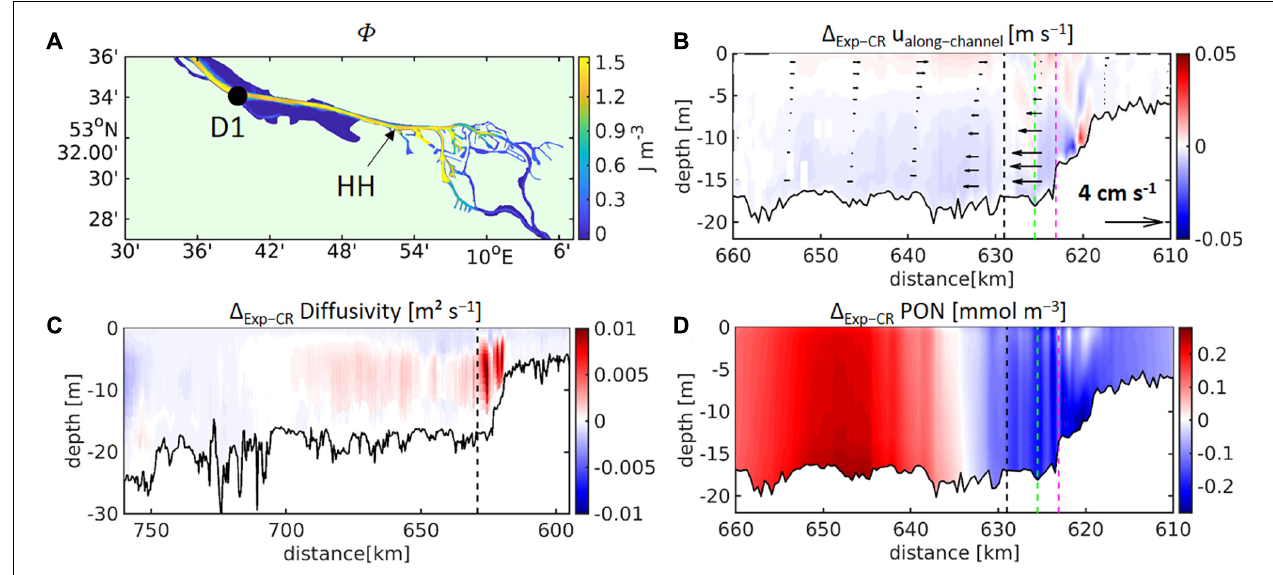
FIGURE 12 | (A) The vertically averaged and time-averaged potential energy anomaly ( (cid:56) ) is given for the focal region of the study, whereas (B) represents the along-channel profile of time-averaged differences experiment-control run ( Exp − CR ) of the vertical eddy diffusivity. Zooming into the deepened freshwater reach, (C) illustrates the time-averaged differences experiment-control run of the along-channel velocity and (D) represents the time-averaged differences of the detritus/particulate organic nitrogen (PON) concentration. The time-averages cover the period May to September, 2012. The black dashed line in (B–D) marks the station “HH” (see Figure 1 ), whereas green and purple dashed line in (B,D) indicate the confluence of northern and southern channel branches and gauge St. Pauli, respectively.